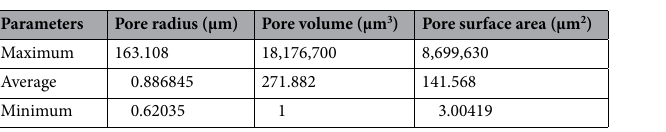
Table 9. Quantitative parameter statistics of pore model in nylon-uncured rubber